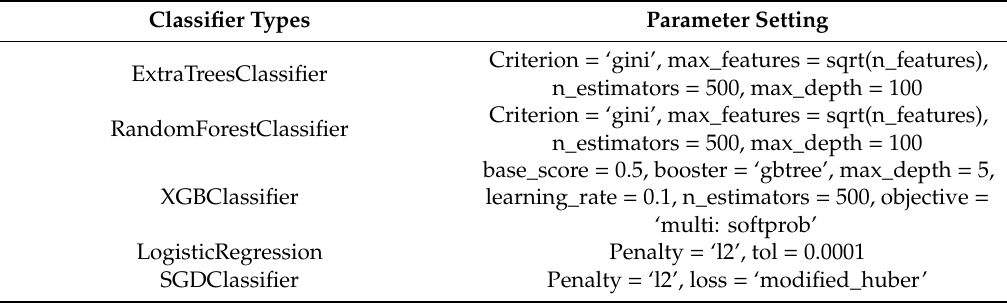
Table 12. Mean classification accuracy of gcForest and built-in classifiers. Table 11. Initial experimental parameter setting of the cascade forest.